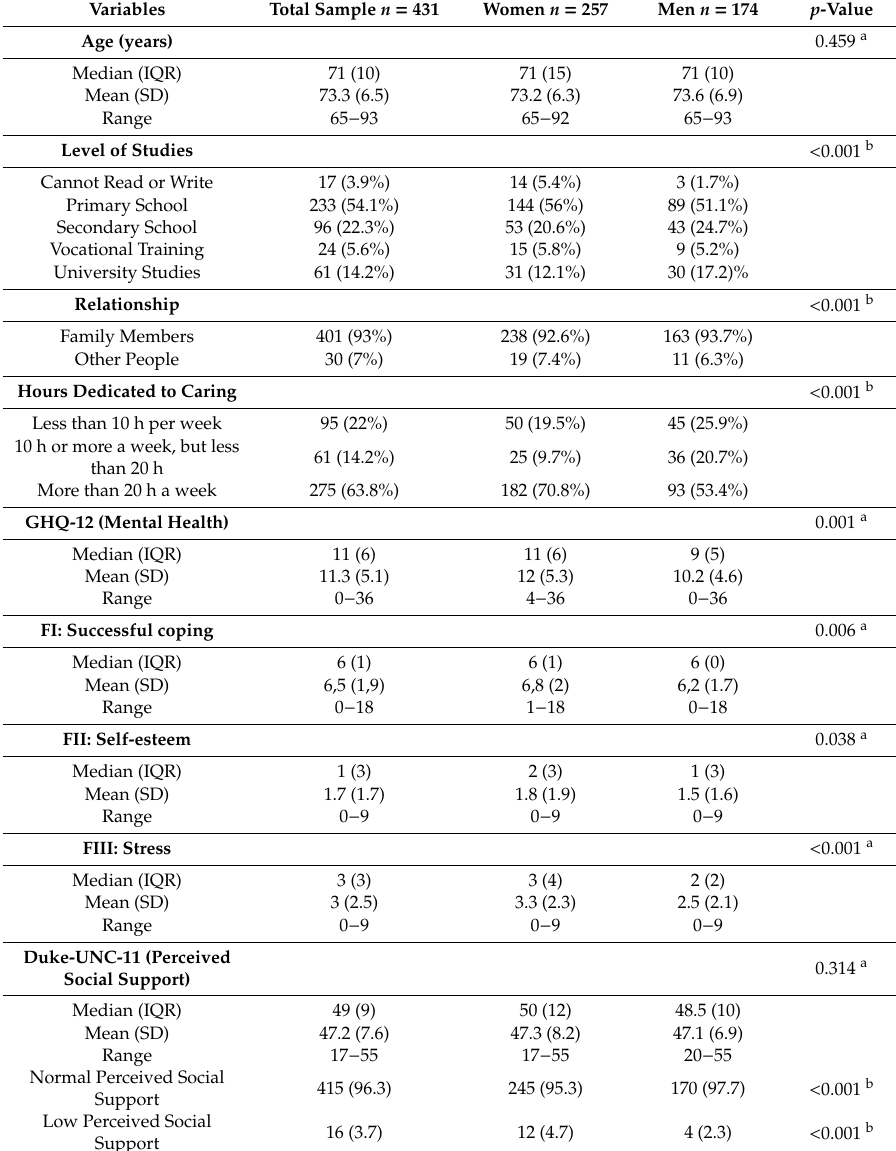
Table 1. Sociodemographic characteristics and dimensions-subscales of the Goldberg General Health Questionnaire GHQ-12 and Duke-UNC Functional Social Support Questionnaire in older caregivers. Spain,